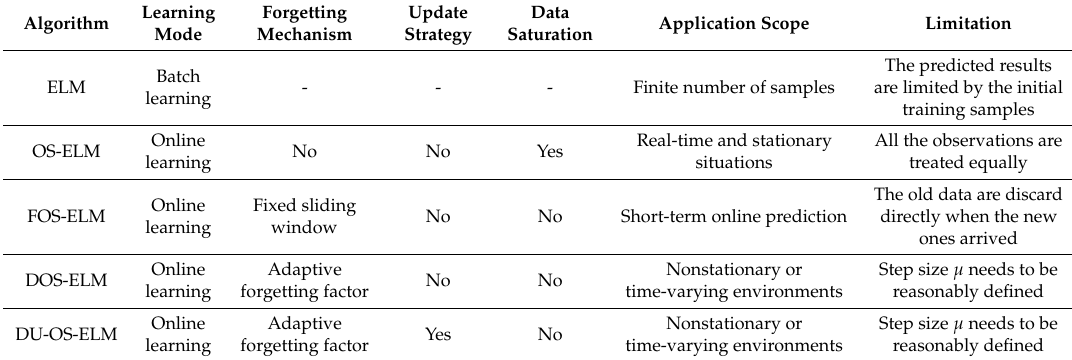
Table 6. Characteristics comparison of different